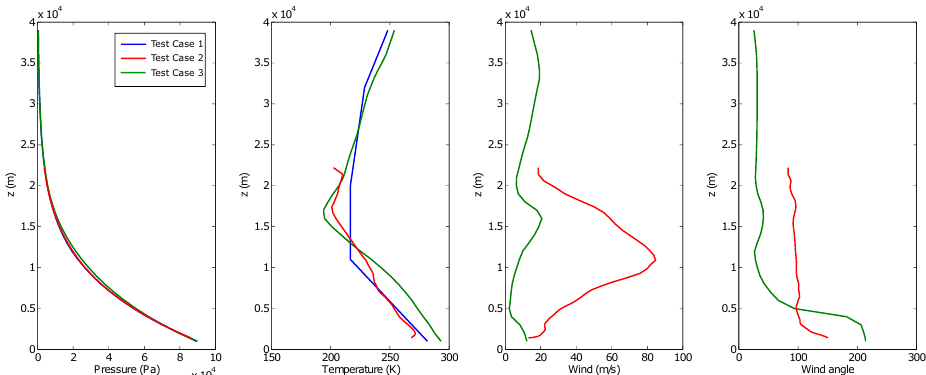
Figure 3. Atmospheric profiles for the three test cases. The height is expressed in meters above sea level, and for all the test cases the vent is located at 1500m above sea level. For the wind profiles, only the profiles for the two test cases with wind are